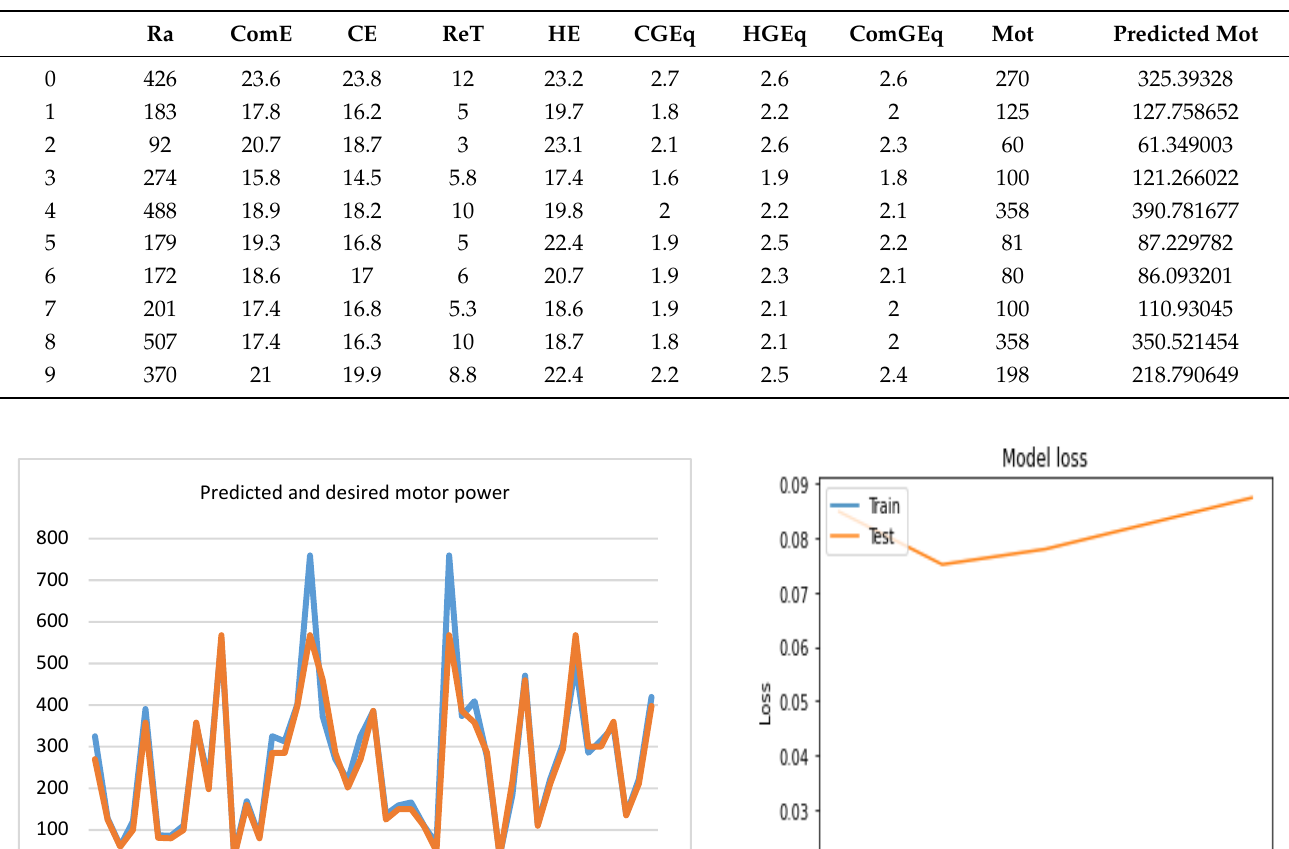
Table 9. Predicted and desired electrical motor power.